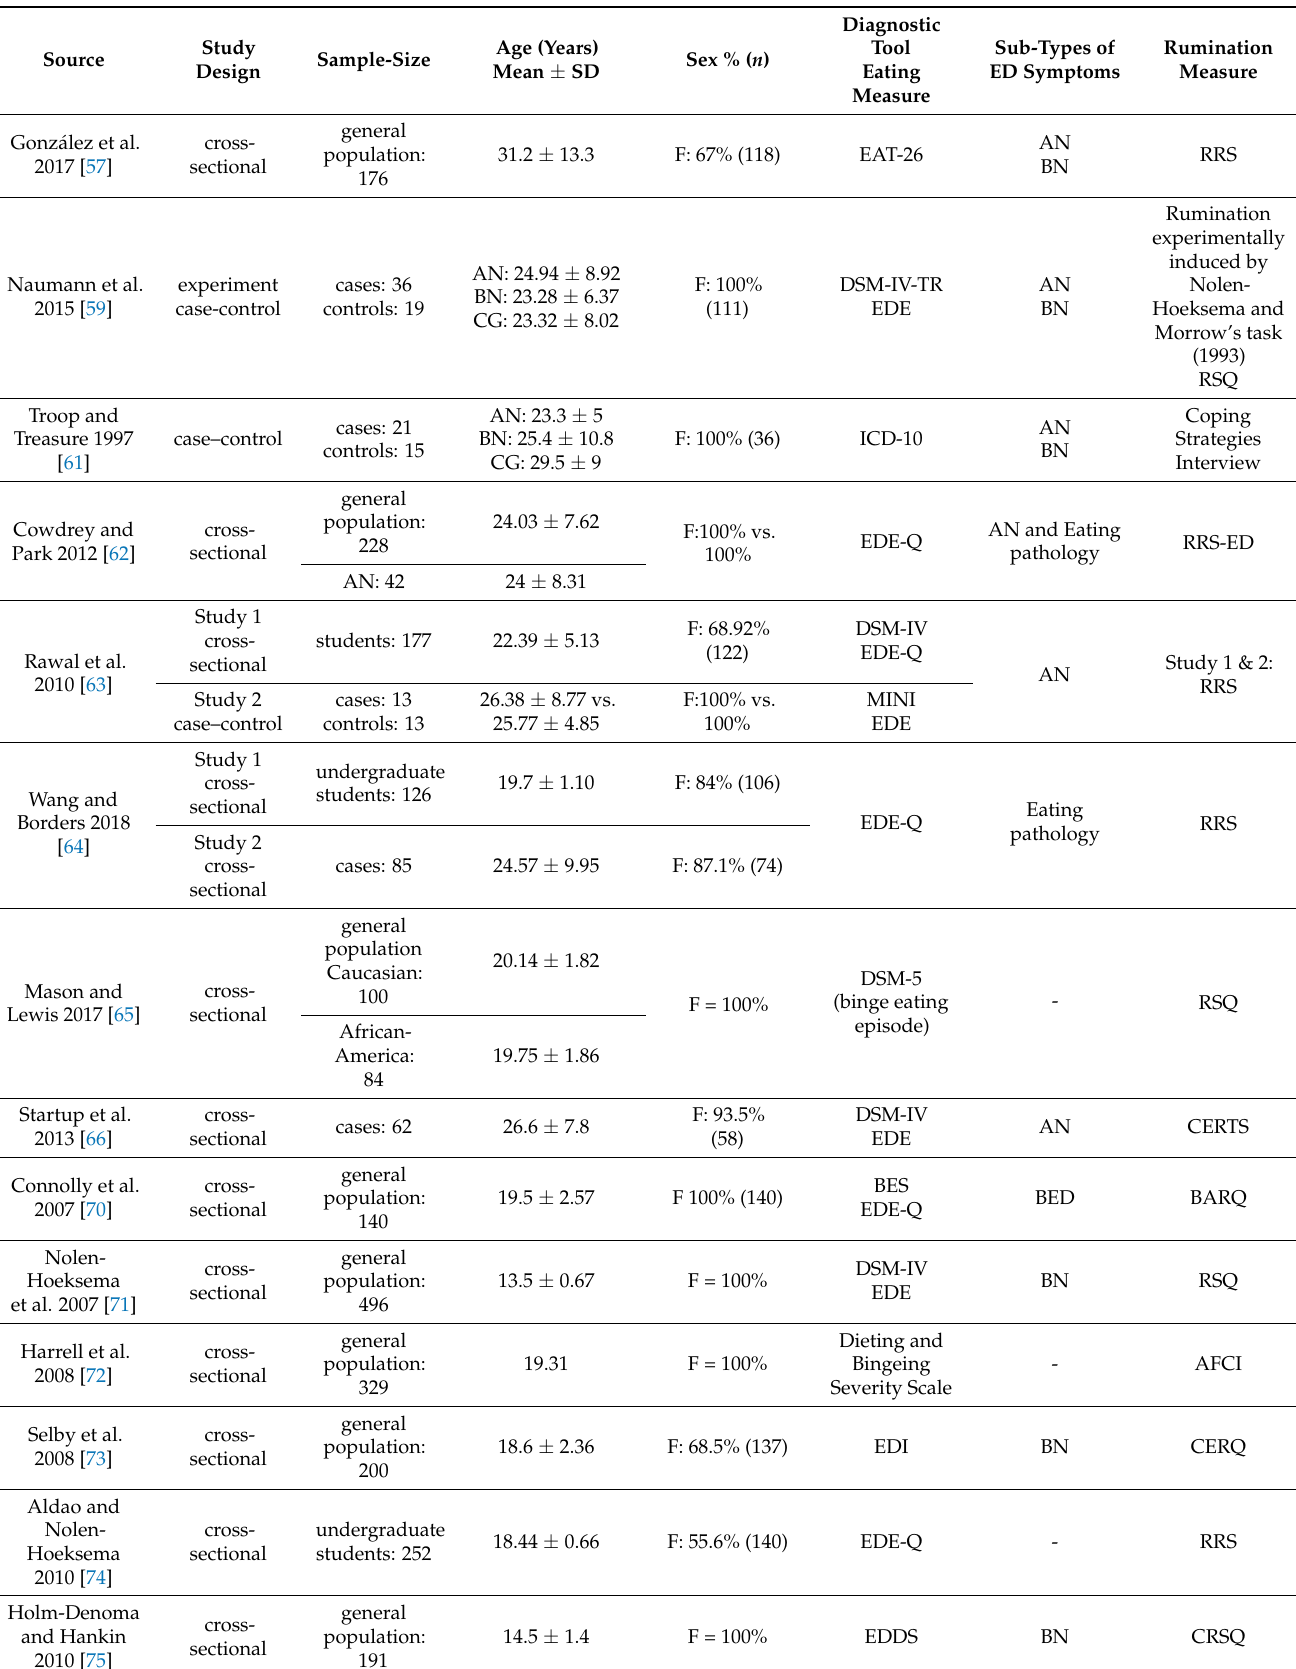
Table 2. Summary of the demographic characteristics of the studies assessed the relationship between rumination and eating